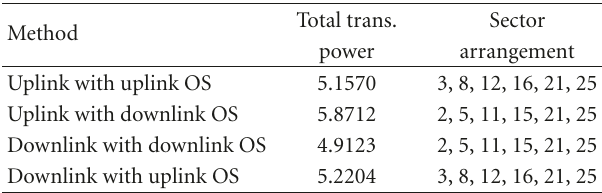
Table 2: Results for the system in Figure 5.